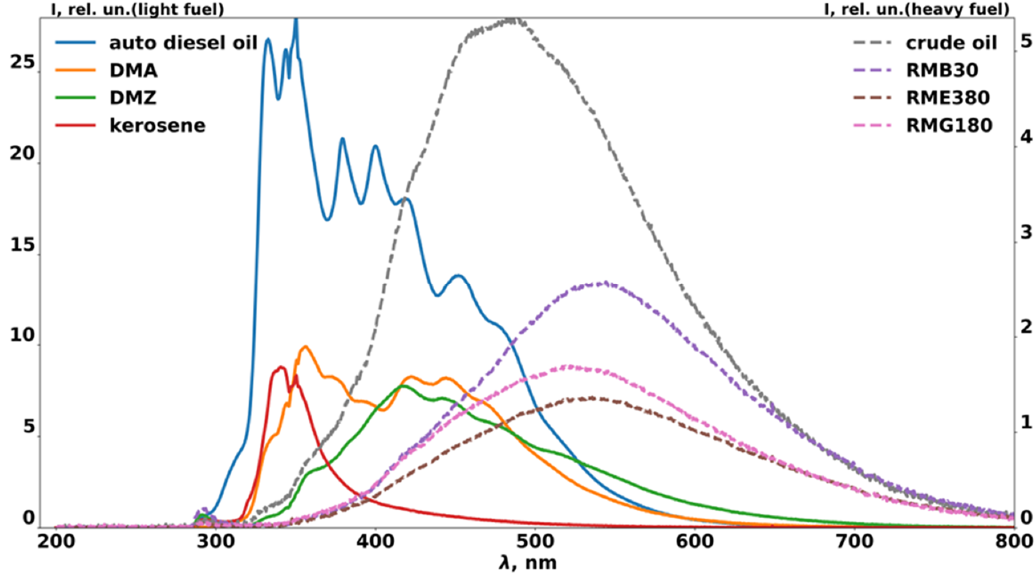
Figure 3. Oil product LIF spectra of the pure state.